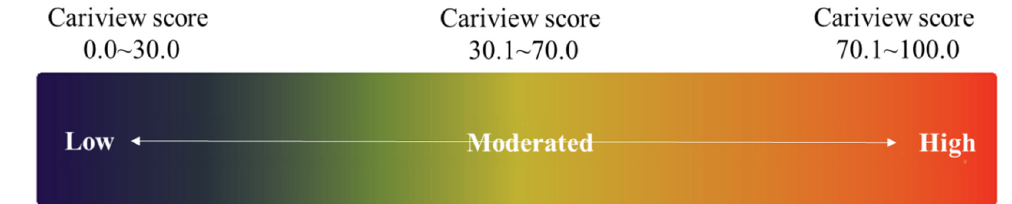
Figure 2. The criteria according to the pH value by the Cariview test.